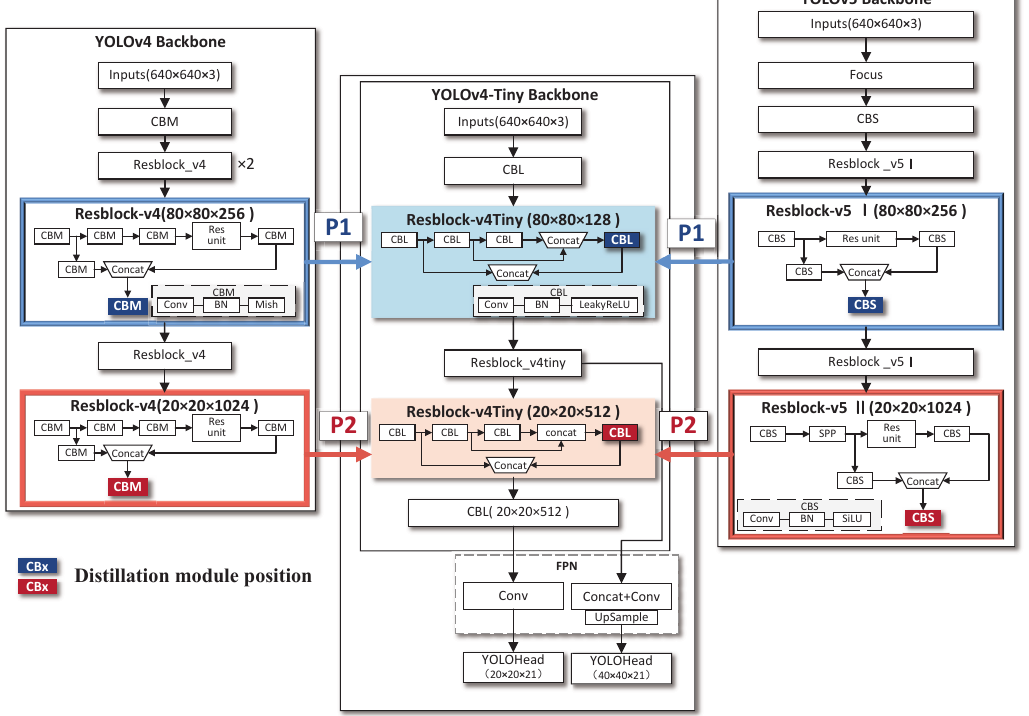
Figure 4. Design framework for feature-distillation position